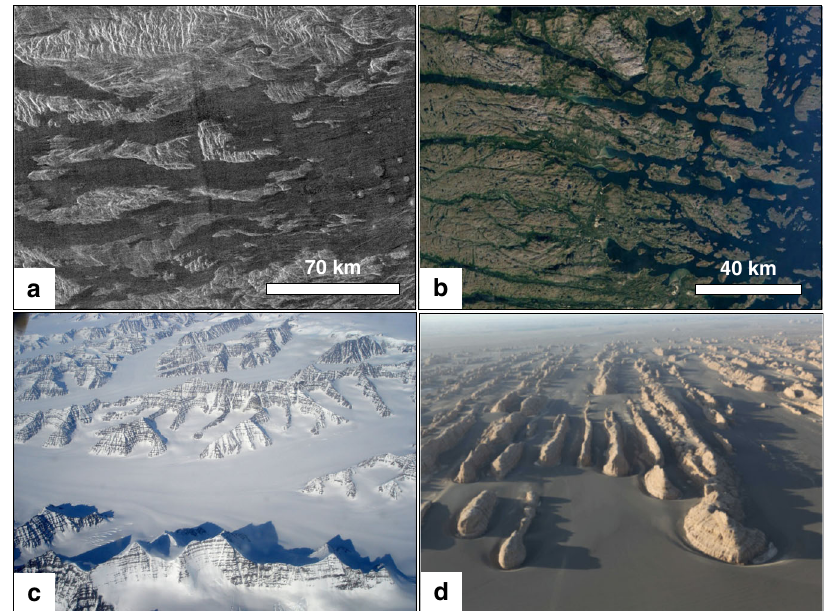
Fig. 2 Recognizing topographic highs above a smooth datum. Comparisons of volcanically fl ooded tessera with topographic highs emerging above a lower, relatively smooth datum on Earth. a Magellan left-looking SAR image from Venus at 6.4°S, 62.1°E (central coordinates) showing portions of tesserae (light grey) surrounded by plains units (dark grey). b Fjords fl ooded by water in Nain, Labrador, Canada (Source: Google maps) (56.5°N, 61.7°W). c Nunataks (high-standing mountains) surrounded and embayed by a fi eld of ice and snow; image from South of Constable point in East Greenland, courtesy of Carl Skou, 2020 http://www.kuummiut.com/2010/03/glaciersnuataks-and-kuummiut.html. d Yardang fi eld bordering the desert of Kumtagh, China (42.7°N, 90.3°E) 52 , with individual features that are hundreds of metres